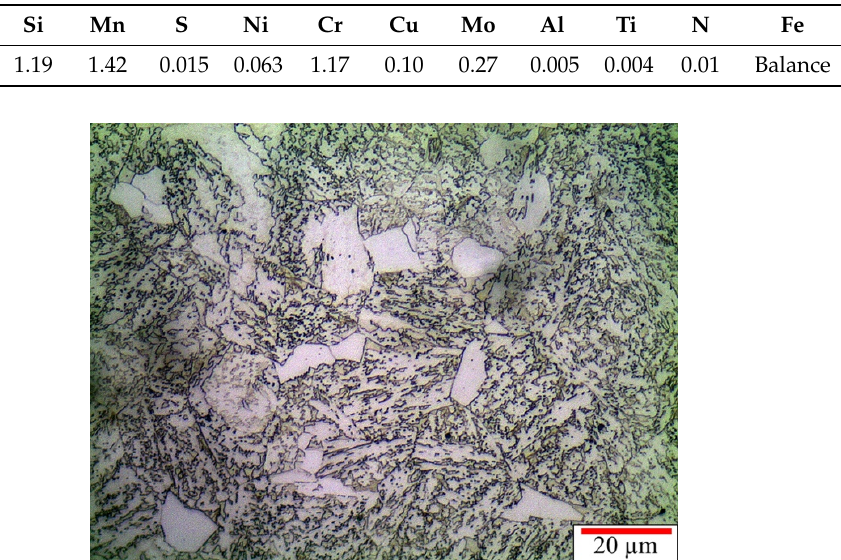
Table 1. Chemical composition (in ma. %).